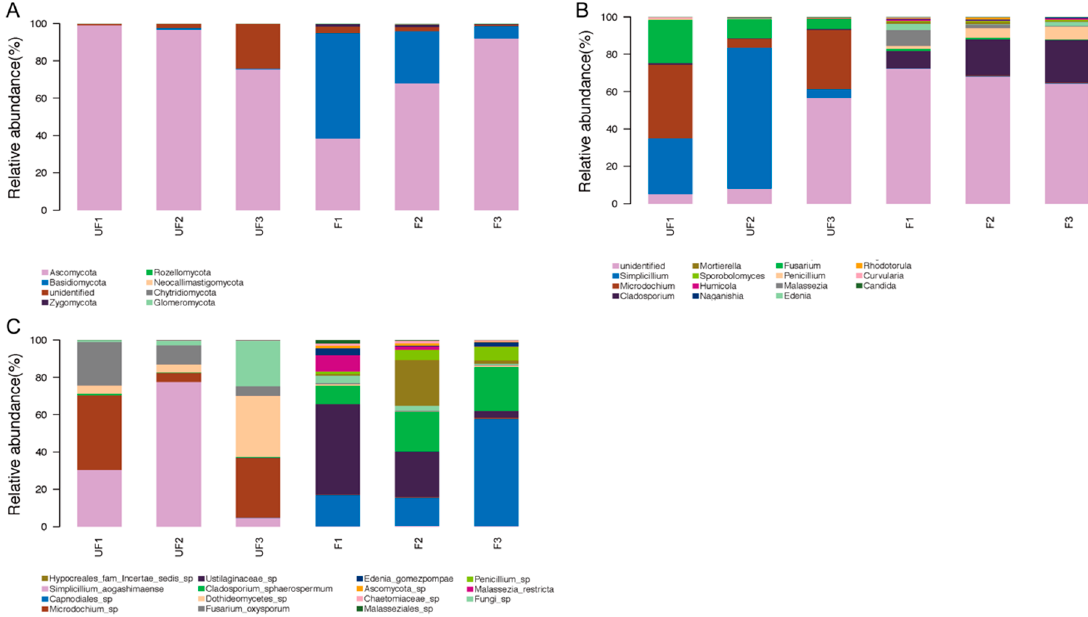
Figure 3. Proportional composition of microbiomes in the non-fertilized and fertilized eggs. ( A ) Composition at the phylum level; ( B ) composition at the genus level; and ( C ) composition at the species level. Groups 1 (including UF1, UF2, and UF3) and 2 (including F1, F2, and F3) represent the non-fertilized and fertilized eggs, respectively.